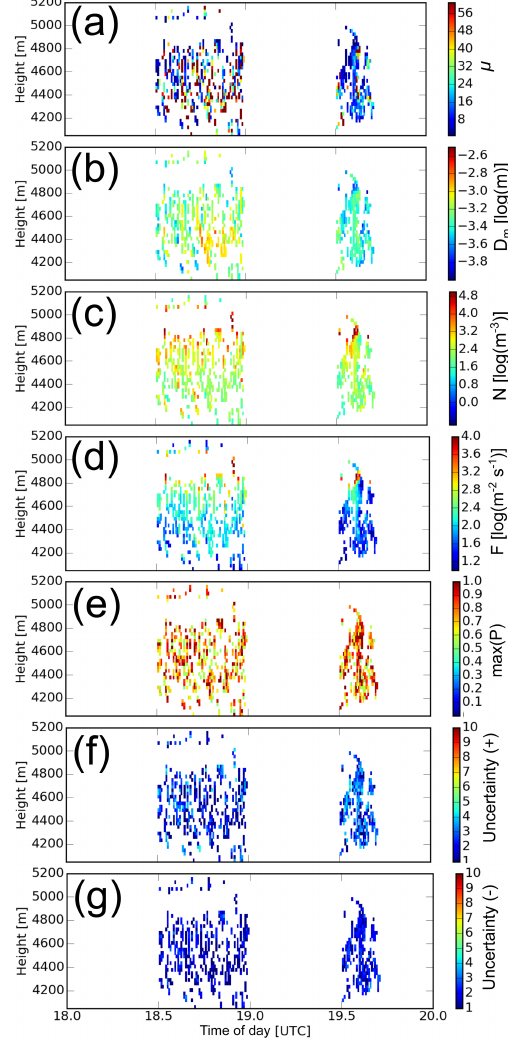
Figure 9. The same as Fig. 8 but with the combined approach taking into account Z/E , v t and w .